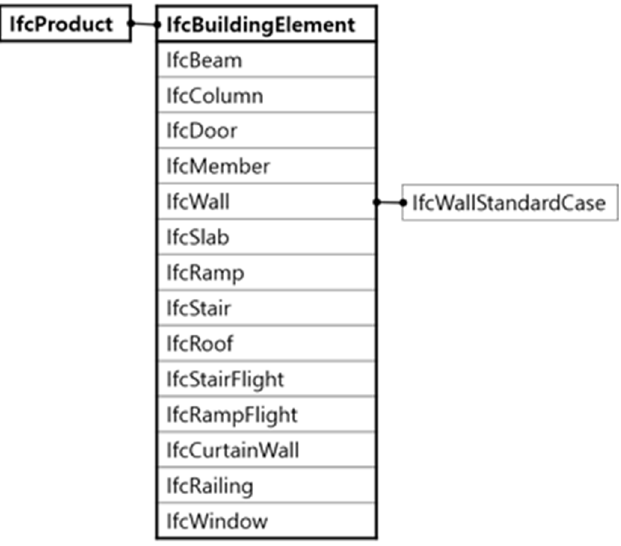
Figure 2. Structure of IfcBuildingElement. 2